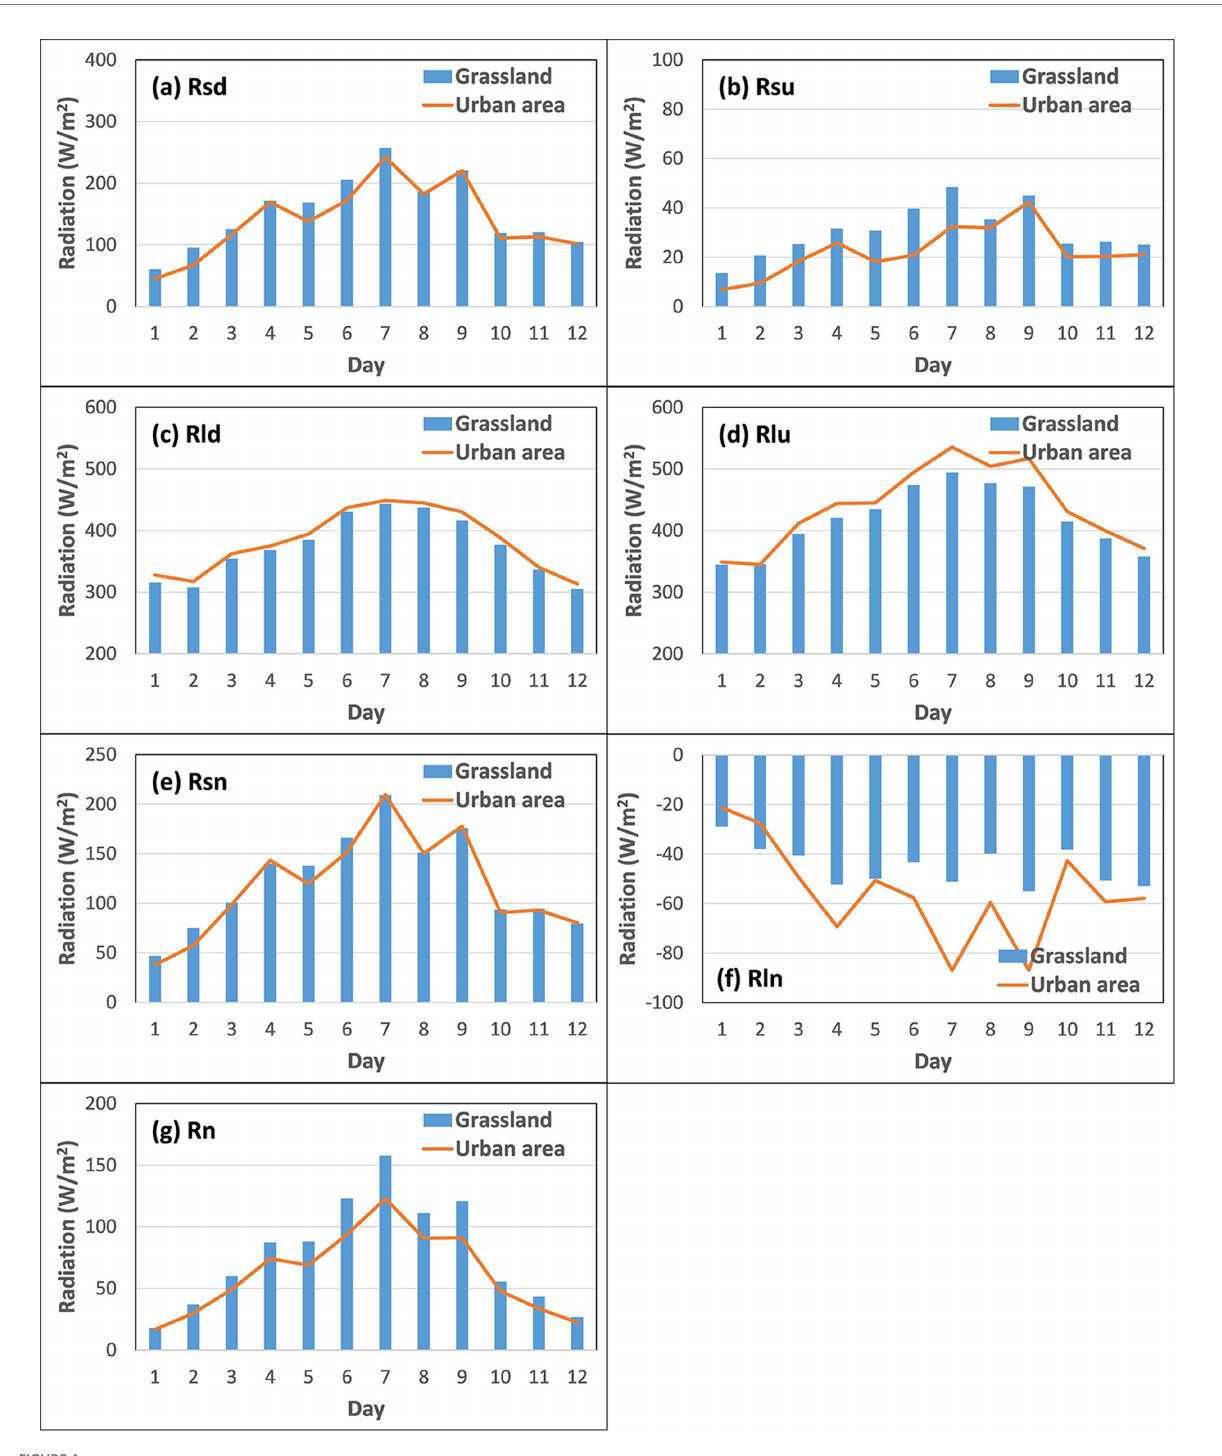
FIGURE 4 Monthly variations in surface radiation among grassland and urban areas for (A) Rsd, (B) Rsu, (C) Rld, (D) Rlu, (E) Rsn, (F) Rln, and (G)